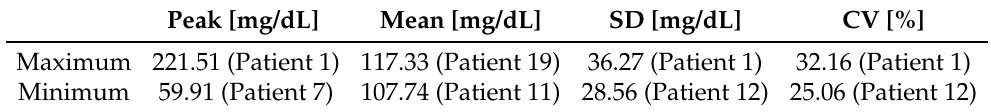
Figure 6. Mean insulin infusion and standard deviation for 20 patients with prior basal therapy. Table 5. Glycemic metrics considering 20 patients and with prior basal